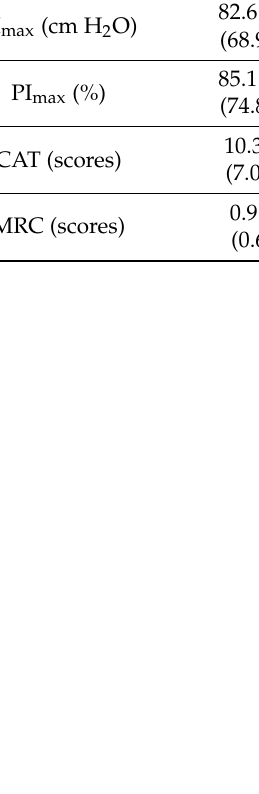
Table 5. RMT effect on the IMV group outcome